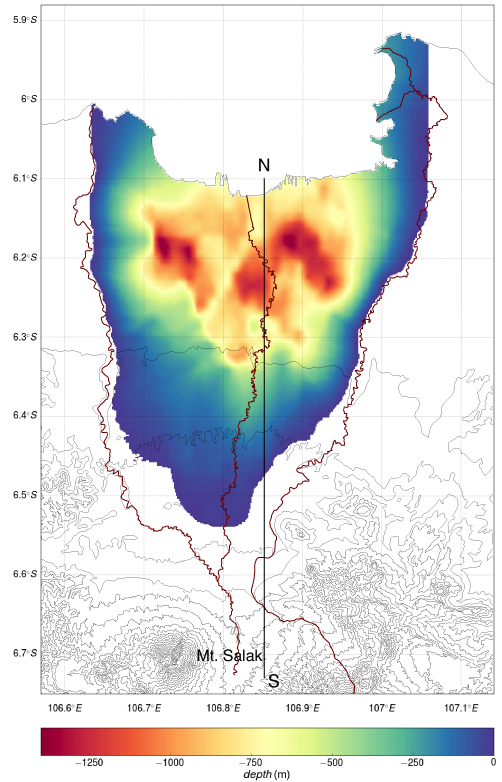
Figure 4. The extended basin model presented here merges the basin model derived from the HVSR technique that covered only the city of Jakarta with the result of the arc (Busk) method that considered geological data to estimate the basin